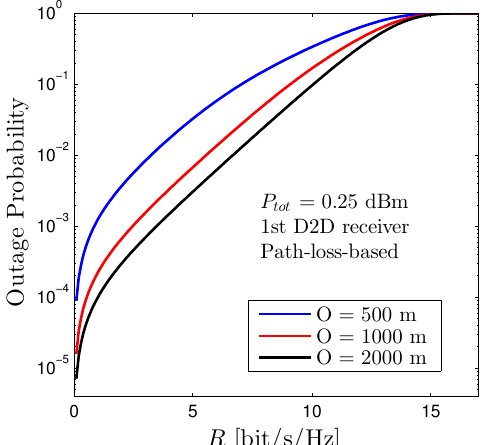
Figure 10. Outage Probability of the first D2D receiver vs. R under various values of network radius O . Solid lines are plotted by employing (12). The location of all devices (both D2D transmitters, receivers, and cellular users) are randomly distributed under the coverage area of the